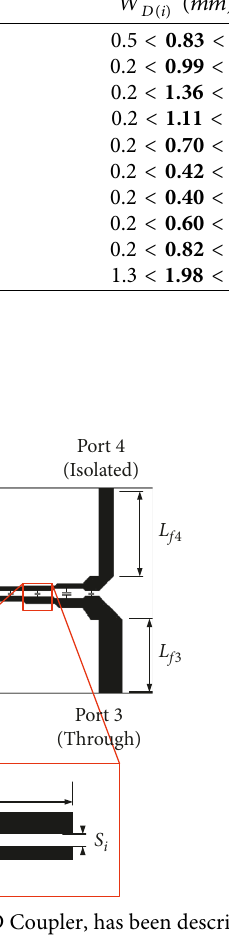
Table 2: Dimension and capacitor value for design 3dB ATRD coupler has been described in Example 1. Section